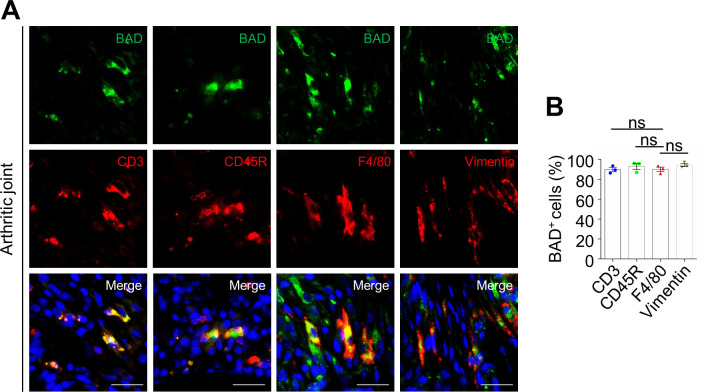
The expression of BAD is not cell-type specific in arthritic joints in collagen-induced arthritis (CIA) model.(A) Double staining of anti-BAD with T cell marker anti-CD3, B cell marker anti-CD45R, macrophage marker anti-F4/80, or synovial fibroblast marker anti-Vimentin respectively in the synovium of wild-type (WT) arthritic mice in CIA model. Scale bar, 25 μm. (B) Quantification of percentages of BAD positive cells in total cells per field of different cell types (n = 3). Data are presented as mean ± SEM; dots represent individual mice. Significant difference was analyzed by one-way ANOVA test.